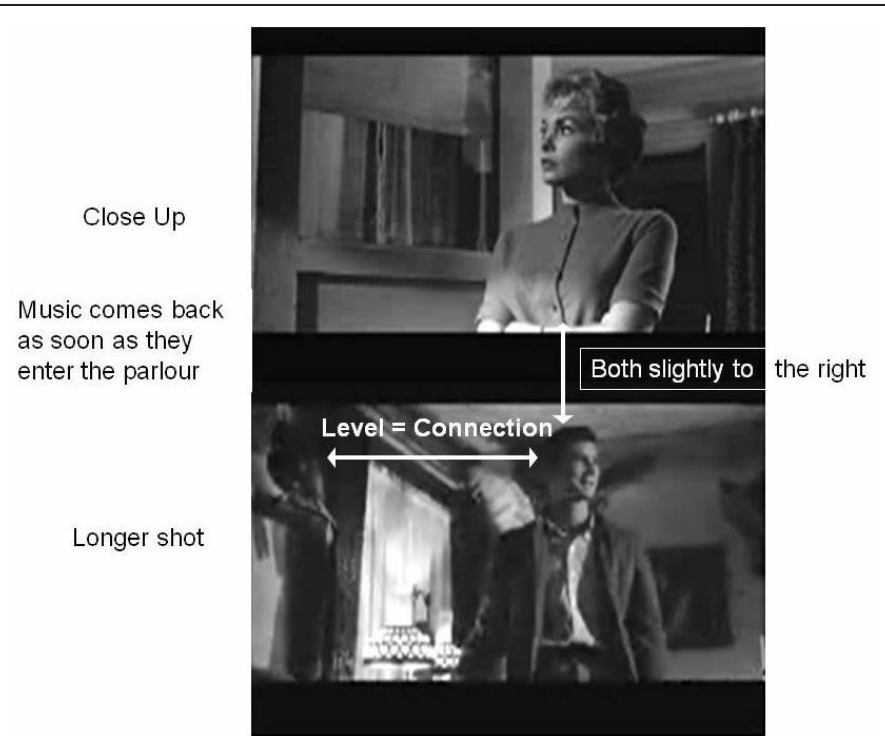
Figure 1: Slide from a 13-year-old student’s PowerPoint ‘essay’ on Psycho